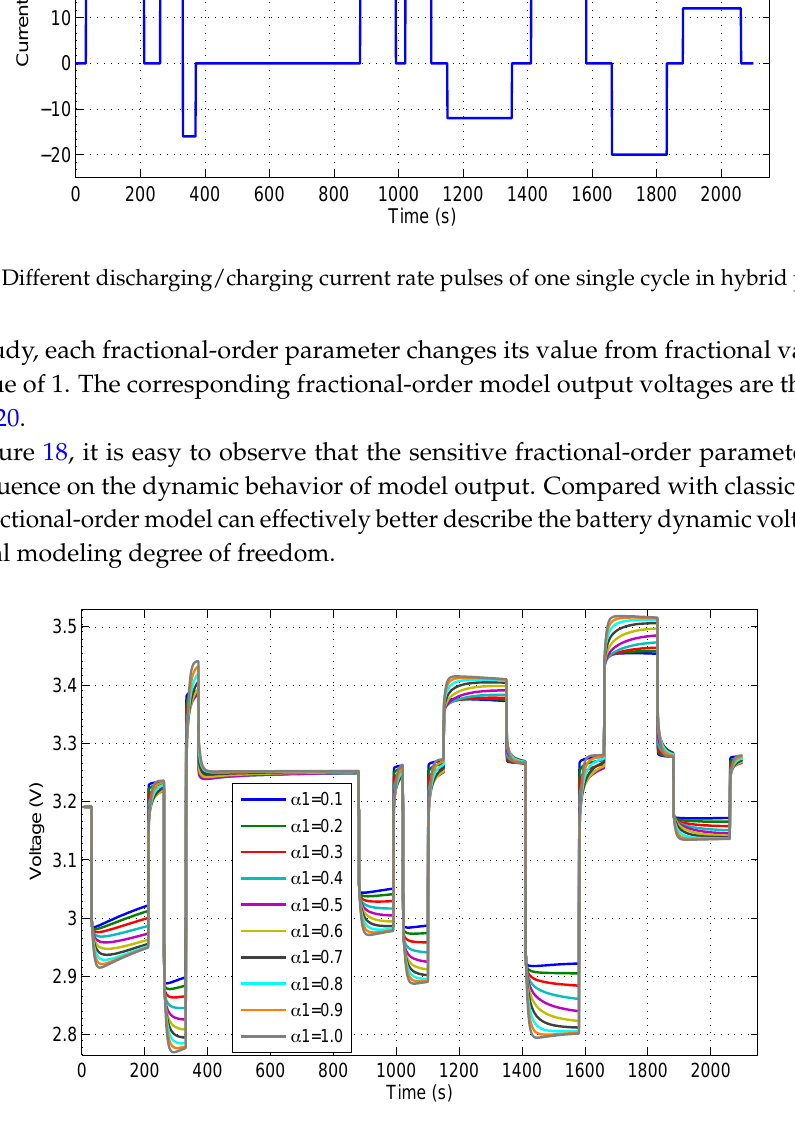
Figure 18. Differences of fractional ‐ order model output voltage by changing value of α (cid:2869) .